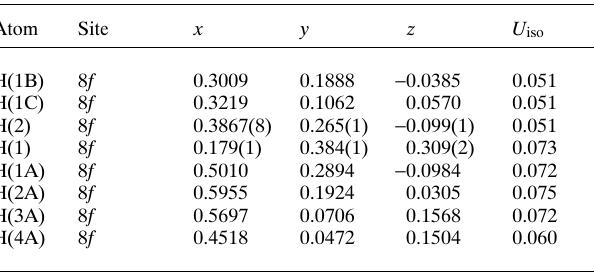
Table 2. Atomic coordinates and displacement parameters (in Å 2 )